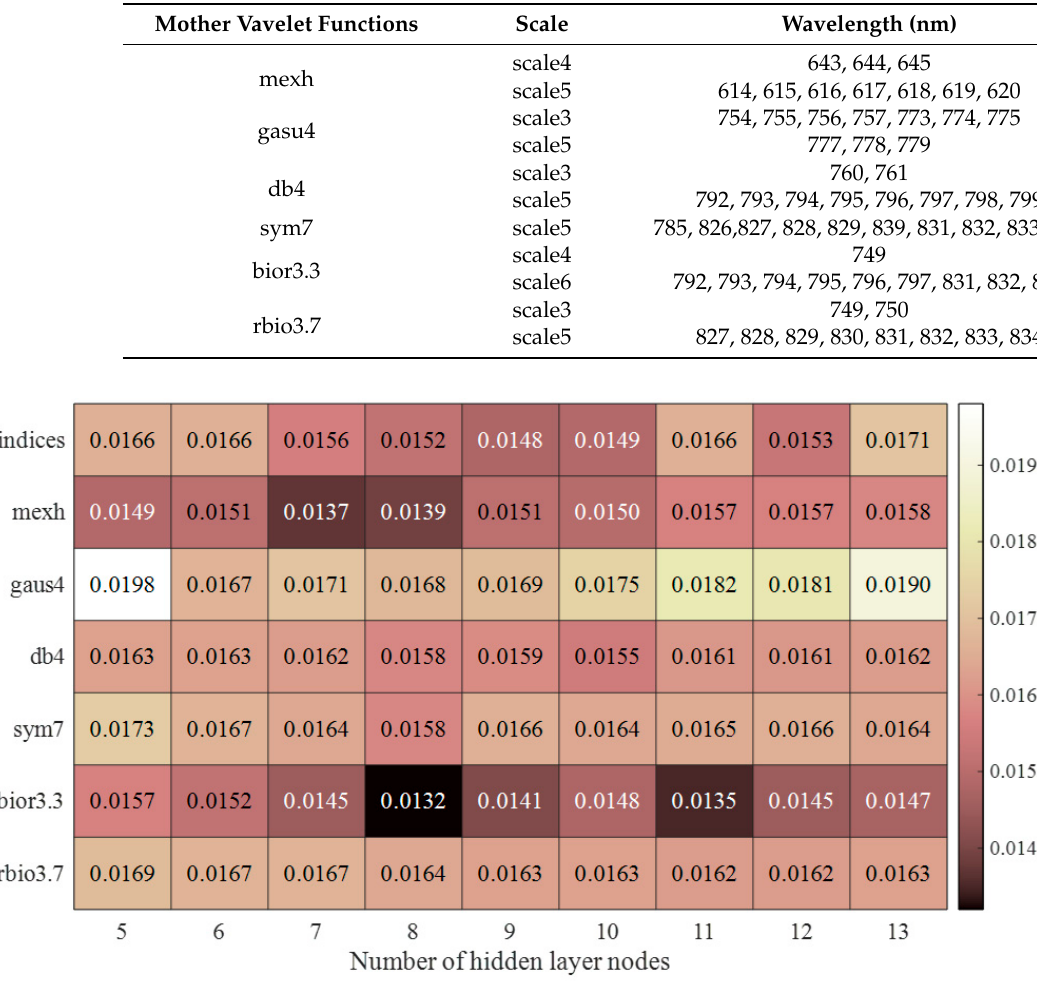
Table 6. The top 10 sensitive bands under different mother wavelet functions.